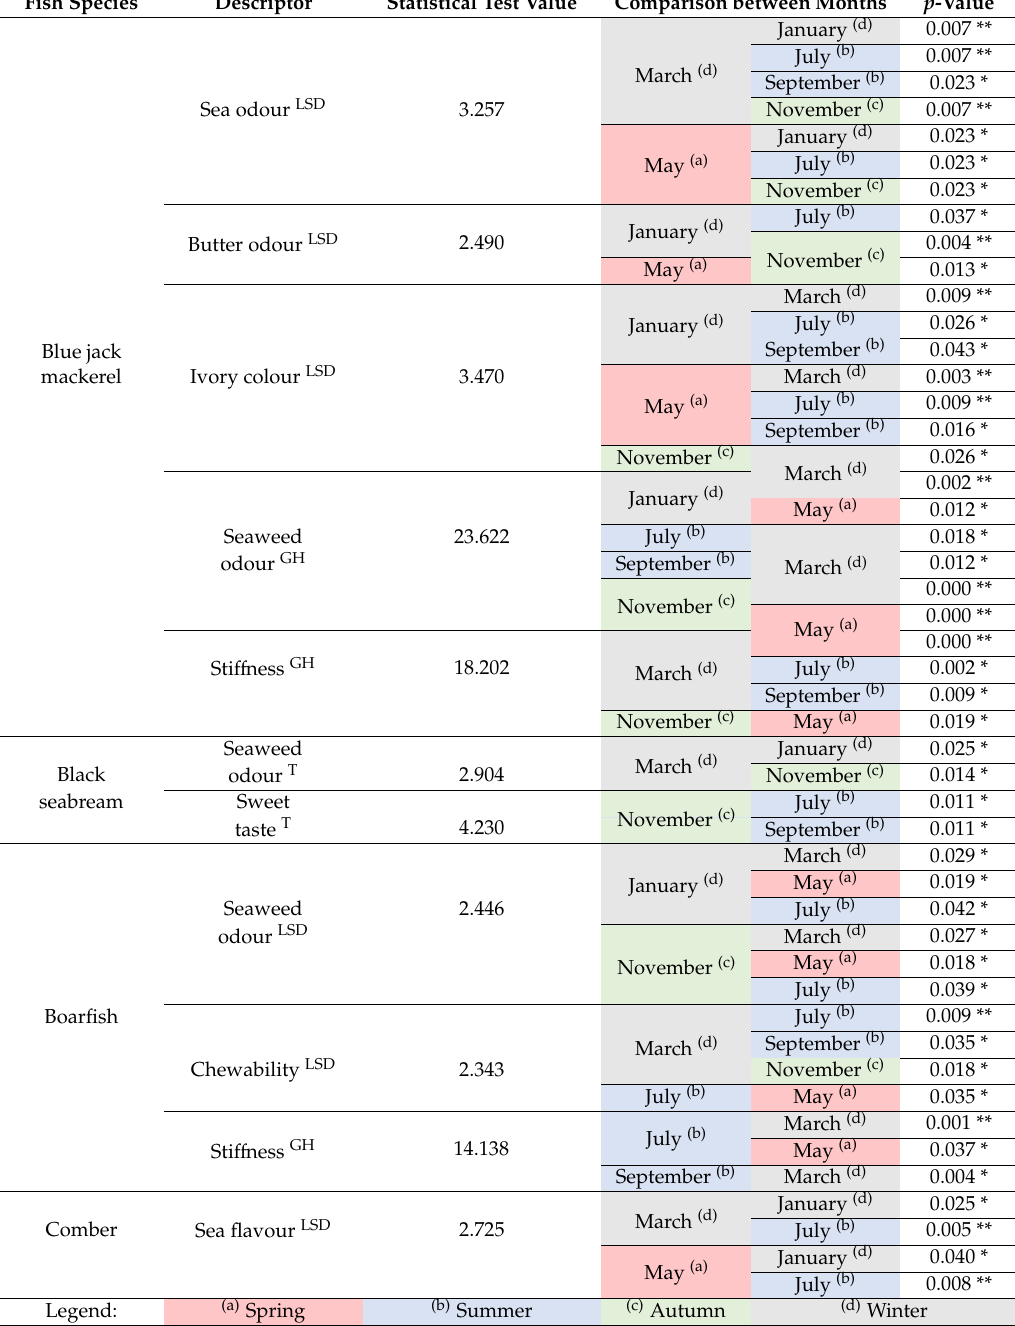
Table 3. Sensory descriptors and statistical test value, for those with statistical di ff erences between months / seasons, according to multiple comparison with LSD (Least Significant Di ff erence), Tukey (T) or Games–Howell (GH) statistical